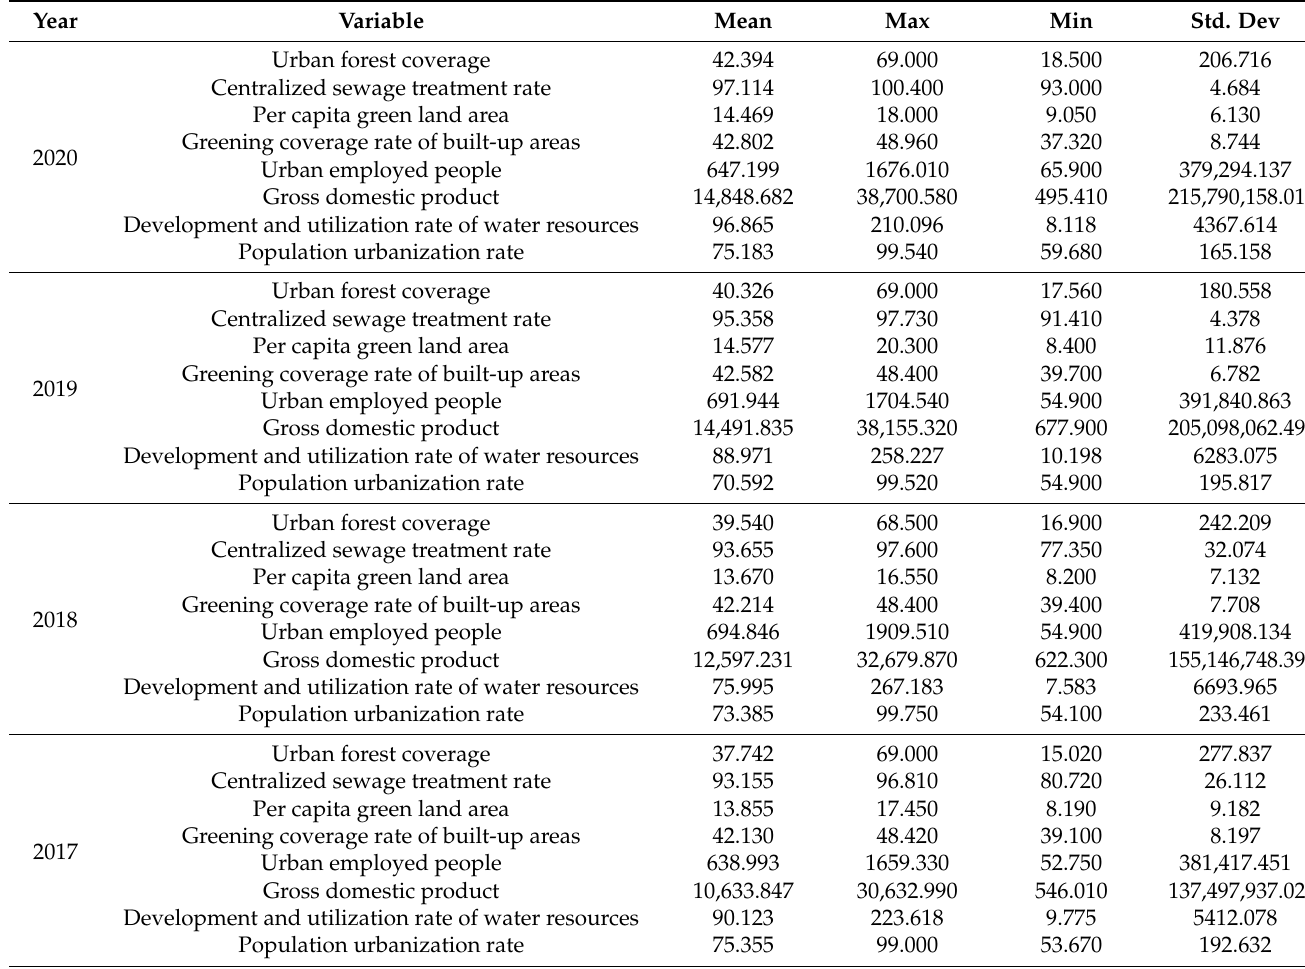
Table 3. Descriptive statistics of the SCC pilots’ main variables from 2017 to